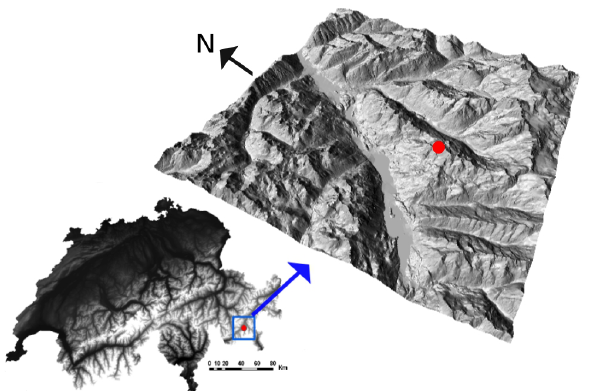
Fig. 6. Study region (25.6 × 25.6km) in the upper Engadin, Switzerland. Location of driving climate station in